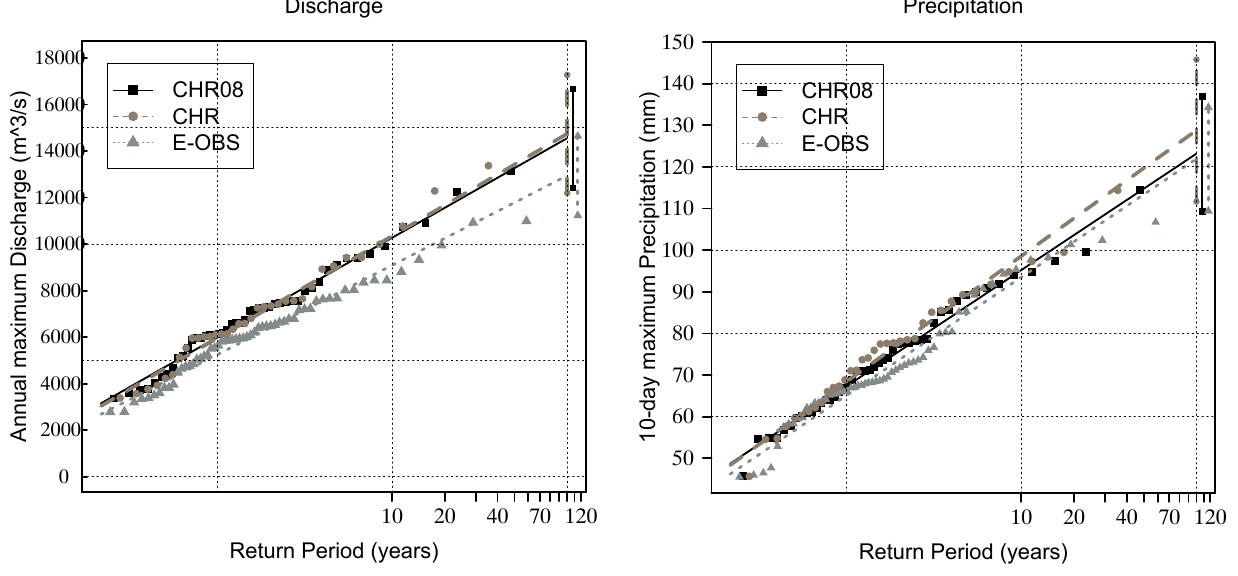
Fig. 3. Gumbel plots of (left panel) annual maximum discharge and (right panel) 10-day precipitation maximum for CHR, CHR08 and E-OBS at Lobith, with the Gumbel fits and the 95% confidence